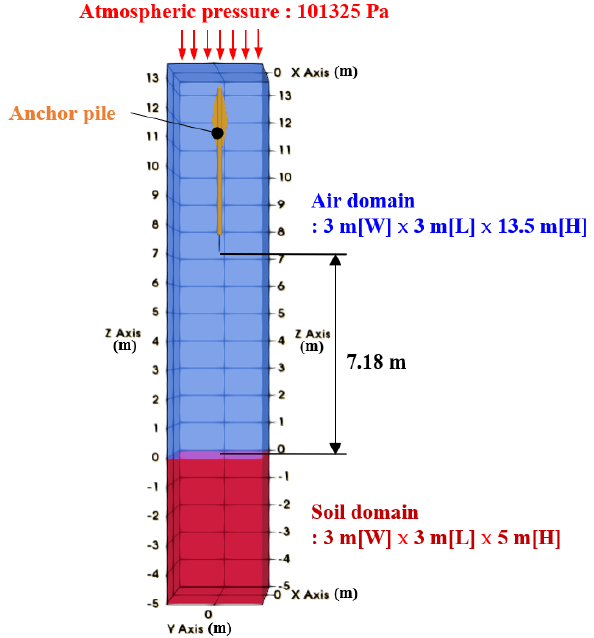
Figure 3. Numerical simulation model of soil penetration.